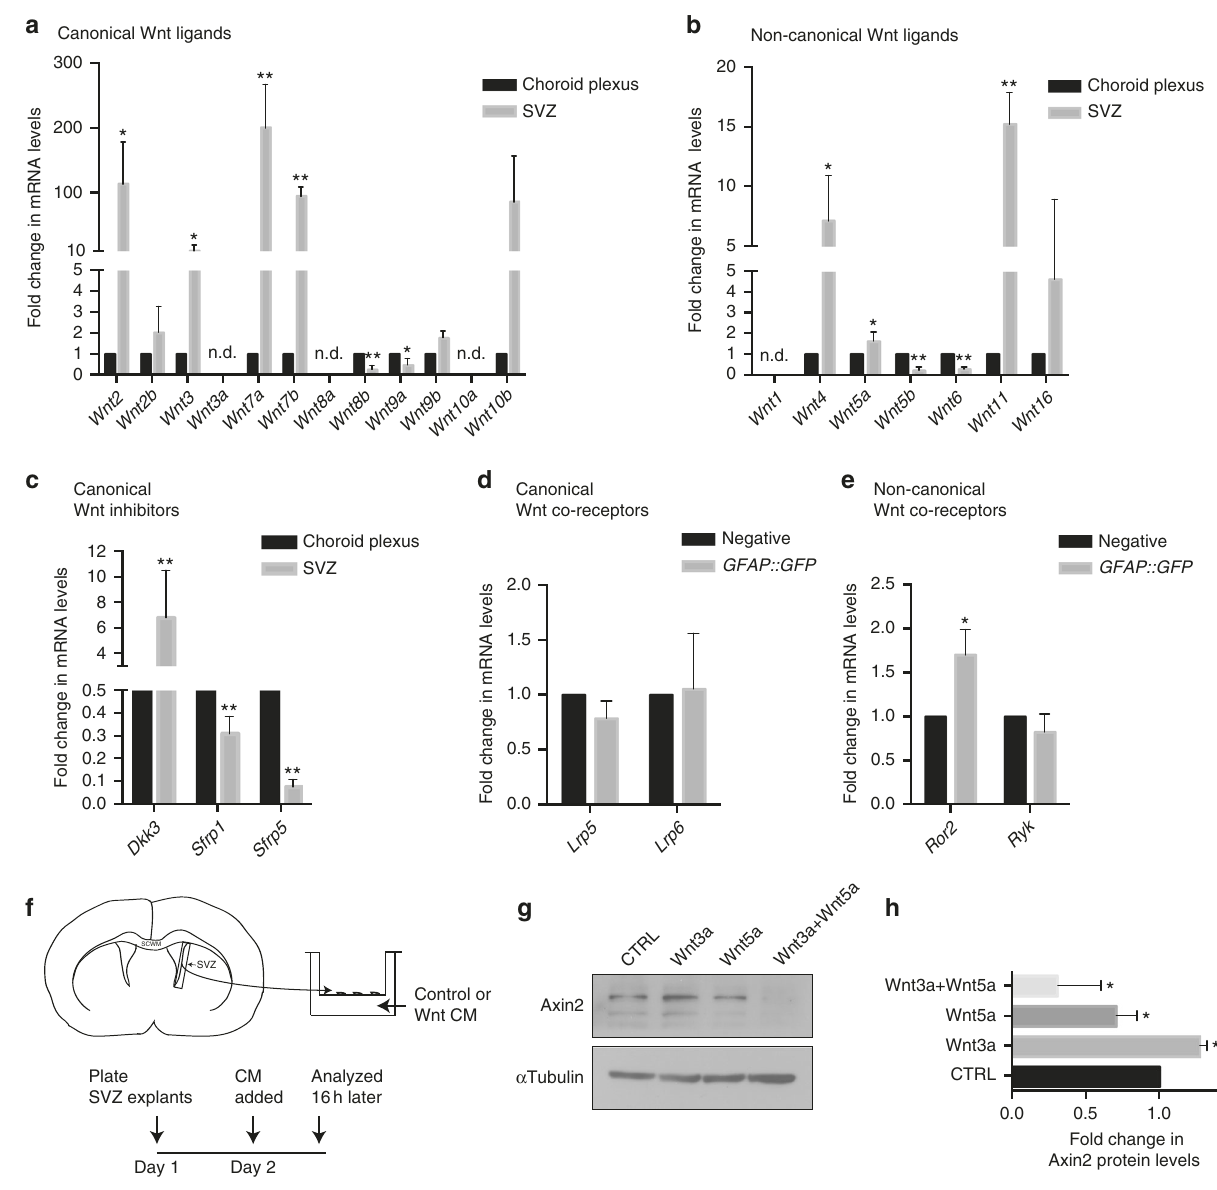
Fig. 2 Differential expression of canonical and non-canonical Wnt pathway elements in the SVZ and choroid plexus. a , b qPCR analysis of a canonical and b non-canonical Wnt ligands generated from reverse-transcribed RNA isolated from the SVZ and choroid plexus tissues of adult mice. Transcript levels of genes in the SVZ are represented as fold change over the levels of the same genes in the choroid plexus (see also Supplementary Data 2). c Transcript levels of canonical Wnt/ β -catenin signaling inhibitors in the SVZ and choroid plexus. d , e SVZ neural stem cells express Wnt co-receptors involved in both d canonical and e non-canonical pathways. Transcript levels of Lrp5, Lrp6, Ror2, and Ryk in sorted GFAP::GFP + cells are represented as fold change over the transcript levels of the same genes in the GFP-negative cells (see also Supplementary Figure 1b). f Schematic showing the SVZ explant culture system and the experimental paradigm for Wnt ligand stimulation and analysis. g Axin2 protein expression in SVZ explants stimulated with Control, Wnt3a, Wnt5a, or Wnt3a+Wnt5a conditioned media. h Densitometry quanti fi cation of Axin2 protein levels (shown in g ; Axin2 protein levels are normalized to α -tubulin levels and represented as a fold change over the control condition). * P < 0.05, ** p < 0.01; error bars represent mean ± s.e.m.; n = 4 for a – e ; n = 3 for h ; n = independent experiments; n.d. not